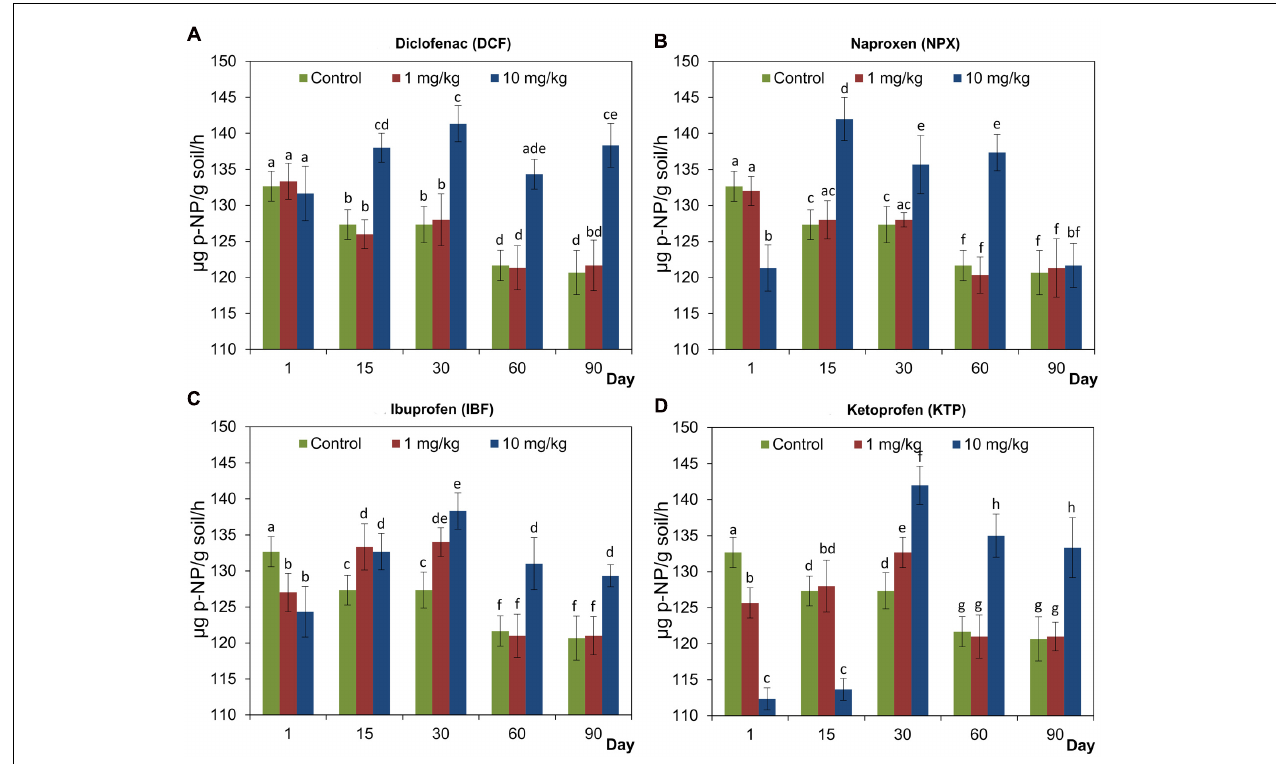
FIGURE 4 | Acid phosphatase (PHOS-H) activity in control soil and soil treated with diclofenac (A) , naproxen (B) , ibuprofen (C) , and ketoprofen (D) at concentrations of 1 and 10 mg/kg soil during the 90-day experiment. The data presented are the means and standard deviations of three replicates and are expressed as µ g p -NP/g soil/h. Different letters (within each drug) indicate significant differences ( P < 0.005, LSD test) related to the effects of concentration and